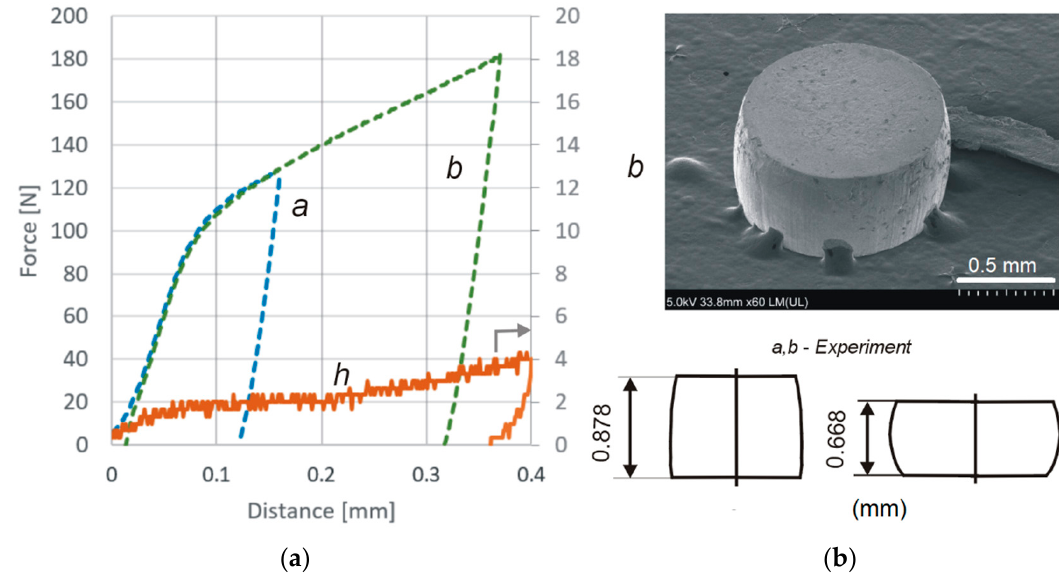
Figure 3. ( a ) Process forces, where a and b are simple upsetting and h is UOM; and ( b ) a deformed specimen (force course b ) and outlines of deformed specimens (force courses a and b